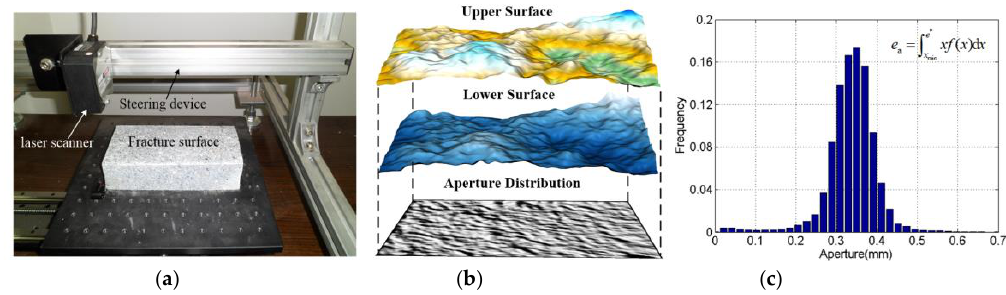
Figure 5. Morphology scanning and aperture reconstruction of a rough fracture: ( a ) Fracture surface morphology scanning [48]; ( b ) fracture aperture reconstruction and correction; ( c ) fracture aperture distribution.